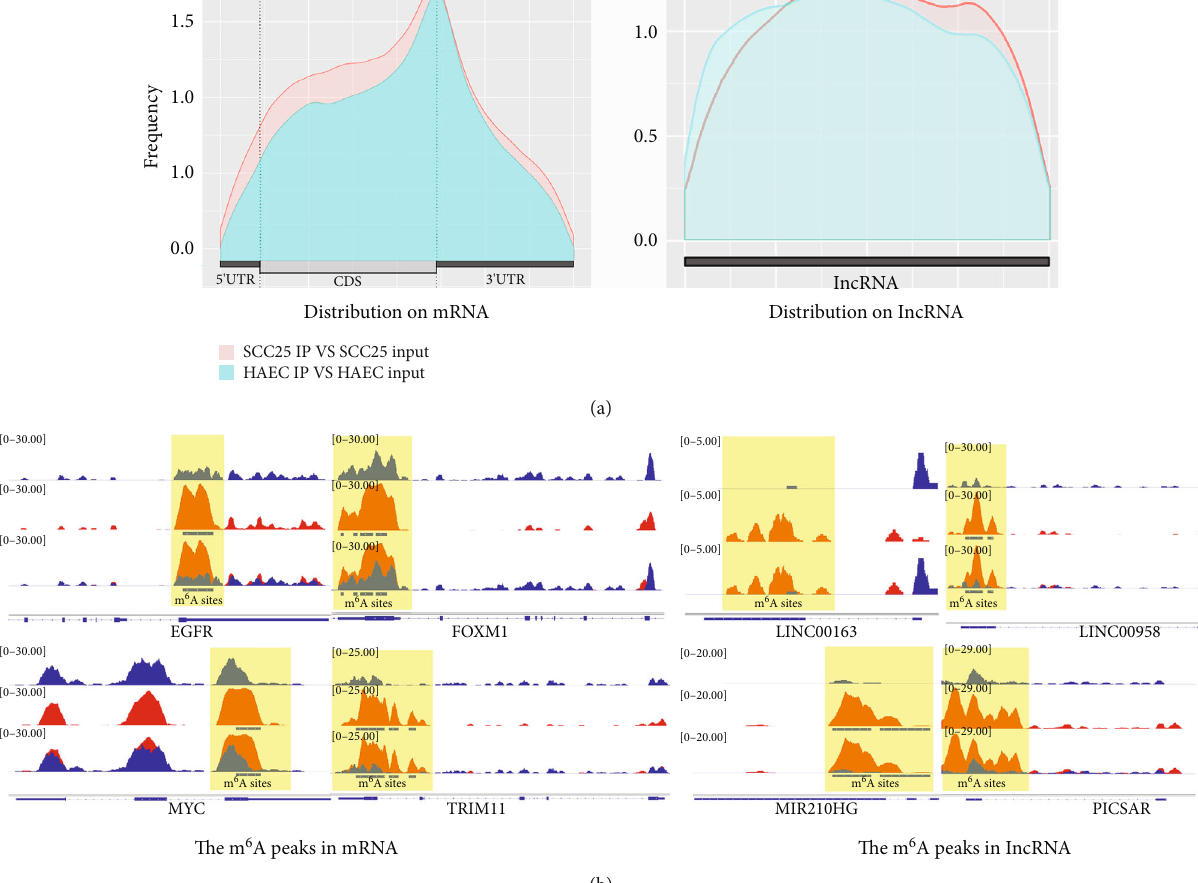
Figure 4: Peak frequency distribution in the transcript area. (a) In theory, the m 6 A peak of mRNAs should be enriched near the 3 ′ UTR. According to the distribution of peaks in the transcript area, the data characteristics can be understood more intuitively. The R software package Guitar was utilized to calculate the frequency of peaks falling on each site in the mRNA and lncRNA transcript regions for each sample, after which, the frequency distribution map was drawn. The abscissa stood for the 5 ′ UTR, CDS, and 3 ′ UTR regions on the mRNA transcript and the entire interval of lncRNA, and the ordinate indicated the frequency of peak falling on these regions. (b) The m 6 A sites were analyzed by the Integrative Genomics Viewer (IGV)